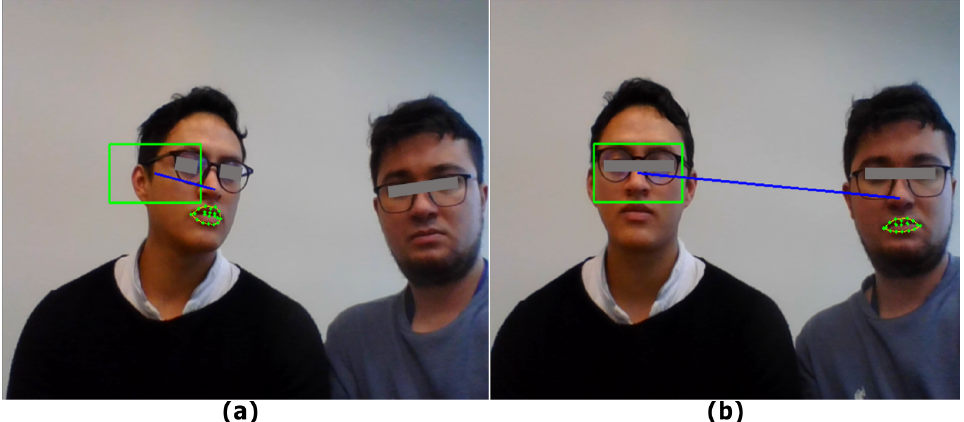
Figure 10. Detection with more than one face. ( a ) Image with correct operation. ( b ) Image with erroneous